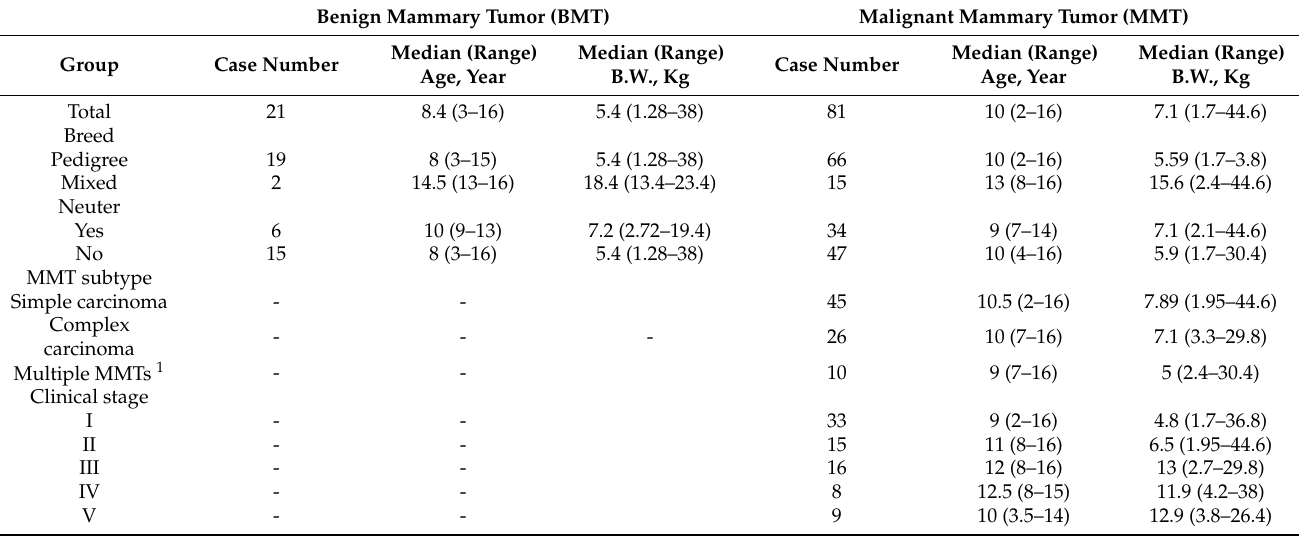
Table 1. Clinicopathological characteristics of 102 female MT dogs enrolled in serum eAGR2